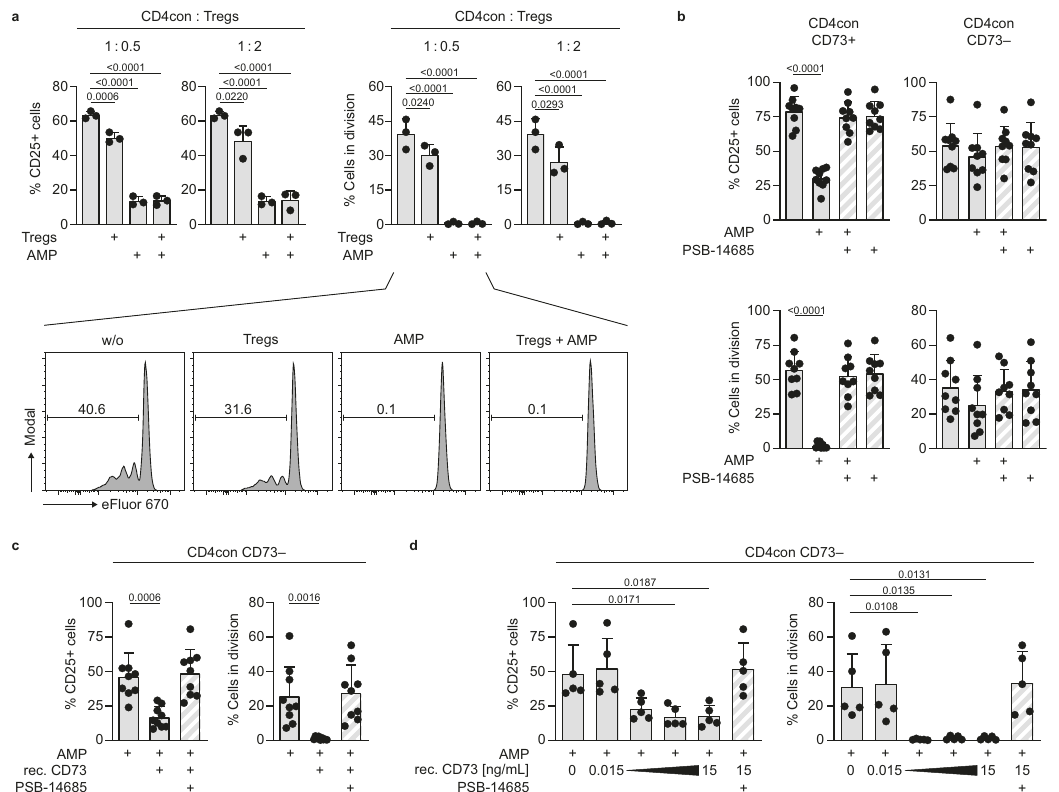
Fig. 2 Treg-derived CD73 is not essential for adenosine-mediated suppression of conventional CD4 T cells. a – d CD4 responder T cells were stimulated with α CD3/ α CD28 in the presence of the ADA inhibitor EHNA (10 µ M). CD25 expression and proliferation were measured after 4 days by fl ow cytometry. a CD4con T cells were stimulated and incubated with AMP (50 µ M) and Tregs in the indicated ratio. b CD4con T cells were sorted into CD73 − and CD73 + , the cells were incubated with AMP (50 µ M) and the speci fi c CD73 inhibitor PSB-14685 (10 µ M). c CD4con CD73 − T cells were incubated with AMP (50 µ M), the speci fi c CD73 inhibitor PSB-14685 (10 µ M), and recombinant CD73 (15 ng/mL). d CD4con CD73 − T cells were incubated with AMP (50 µ M) and different concentrations of soluble recombinant CD73 (three tenfold serial dilutions starting with 15 ng/mL). PSB-14685 was used to block the highest concentration of recombinant CD73. Data were shown for a three, b , c nine and d fi ve donors (mean ± SD). Ordinary one-way ANOVA with Dunnett ’ s multiple comparisons test was used to compare all conditions to cells treated with EHNA or EHNA and AMP ( fi rst with improved signal-to-noise sensitivity using fl uorescent 1, N 6 - etheno-AMP (eAMP) as a substrate to measure AMPase activity in cells and cell culture supernatants (Fig. 3b). As a proof of principle, we forced shedding of cell surface CD73 on CD8 T cells using phosphatidylinositol-speci fi c phospholipase C (PI-PLC) (Fig. 3c, left) and observed lower AMPase activity of the PI-PLC-treated cells compared to untreated cells (Fig. 3c, middle). In contrast, the supernatants from PI-PLC treated cells converted more eAMP to 1, N 6 -etheno-adenosine (eADO), in line with a higher amount of CD73 present in the supernatant (Fig. 3c, right). The CD73-speci fi c inhibitor PSB-14685 completely blocked eAMP degradation, verify- ing the speci fi city of the AMPase activity. Activated T cells that had lost CD73 expression (Fig. 3d, left), showed lower AMPase activity than unstimulated cells (Fig. 3d, middle). This decrease in activity in the cell-bound compartment was paralleled by increased generation of eADO in the cell culture supernatant of activated cells and accompanied by an increase in the concentration of soluble CD73 detected by ELISA (Fig. 3d, right). These data demonstrate that CD73 is released in the cell culture supernatant upon T cell activation and retains its enzymatic activity.